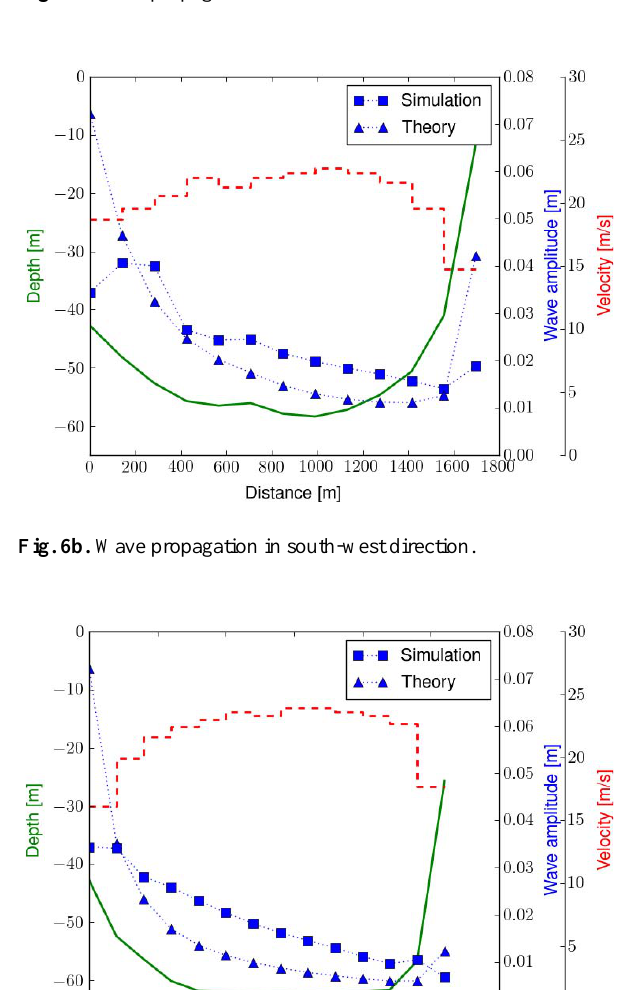
Fig. 6a. Wave propagation in west direction.